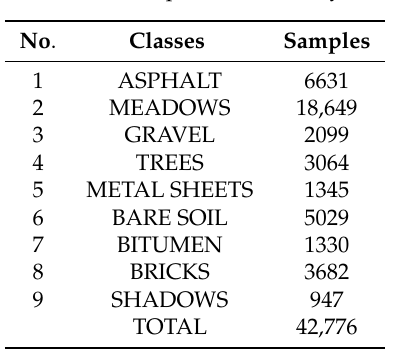
Figure 7. The groundtruth of University of Pavia. Table 2. Labeled samples in University of